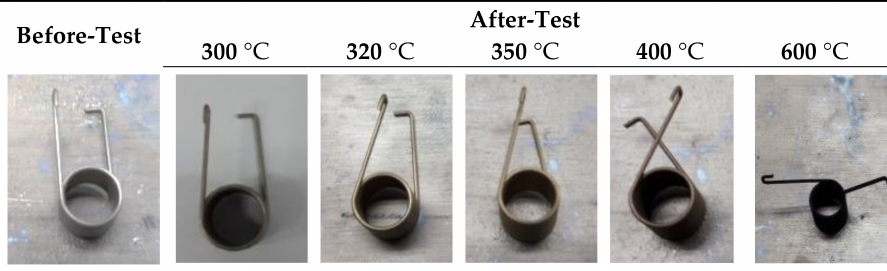
Figure 6. The jig plate ( left ) and a zig shape firmly fixing a return-spring ( right ).